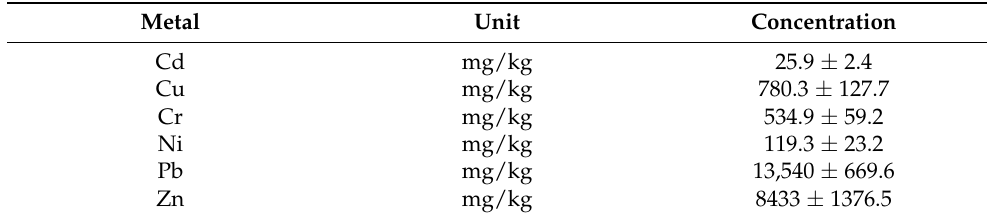
Table 1. The contents of heavy metals (HMs) in the soil from degraded areas, used in the experiment (n = 3, mean ± standard deviation).